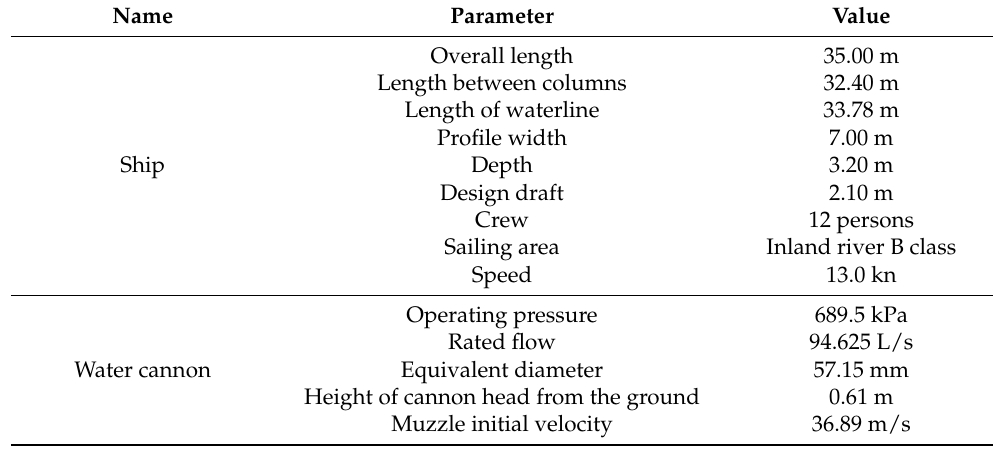
Table 4. Parameters of the fireboat.